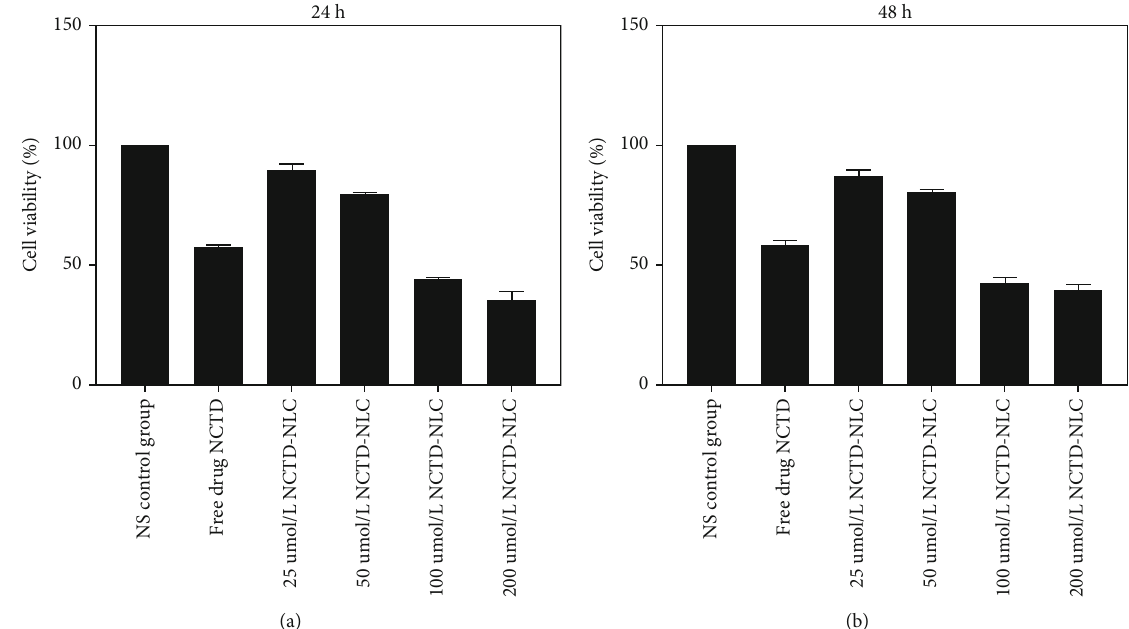
Figure 1: MTT detection of hepatoma cell proliferation after NCTD-NLC treatment. (a) 24 h after treatment in each group, MTT assay was conducted to estimate cell viability. (b) After 48 h treatment in each group, MTT assay was conducted to estimate cell